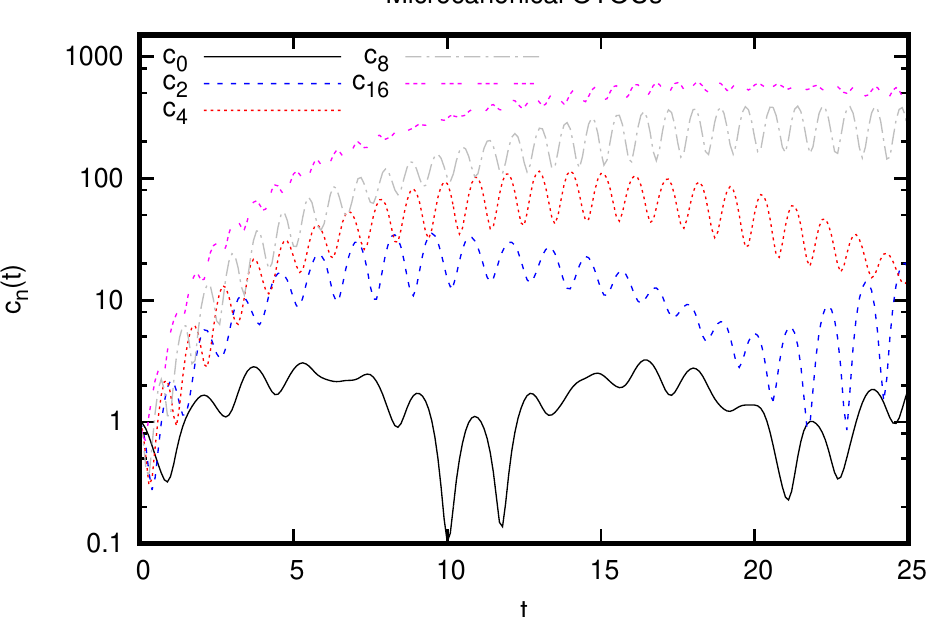
Figure 2 . Microcanonical OTOCs c n ( t ) as a function of time for n = 0 , 2 , 4 , 8 , 16 (OTOCs for odd n are qualitatively